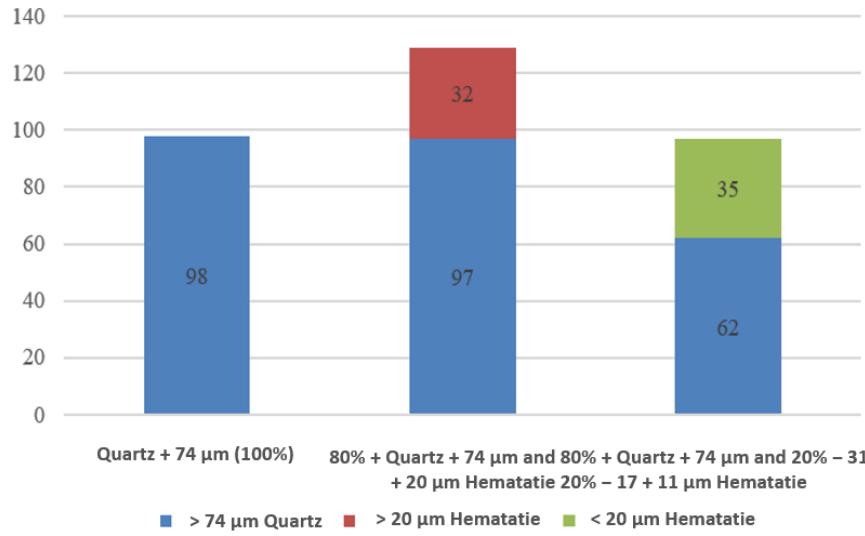
Figure 8. E ff ect of + 20 µ m and − 20 µ m hematite on the floatability of + 74 µ m quartz (100 g / t of Figure 8. Effect of +20 µm and −20 µm hematite on the floatability of +74 µm quartz (100 g/t of etheramine 7100 by Clariant, 500 g / t corn starch, and pH etheramine 7100 by Clariant, 500 g/t corn starch, and pH 10.5).